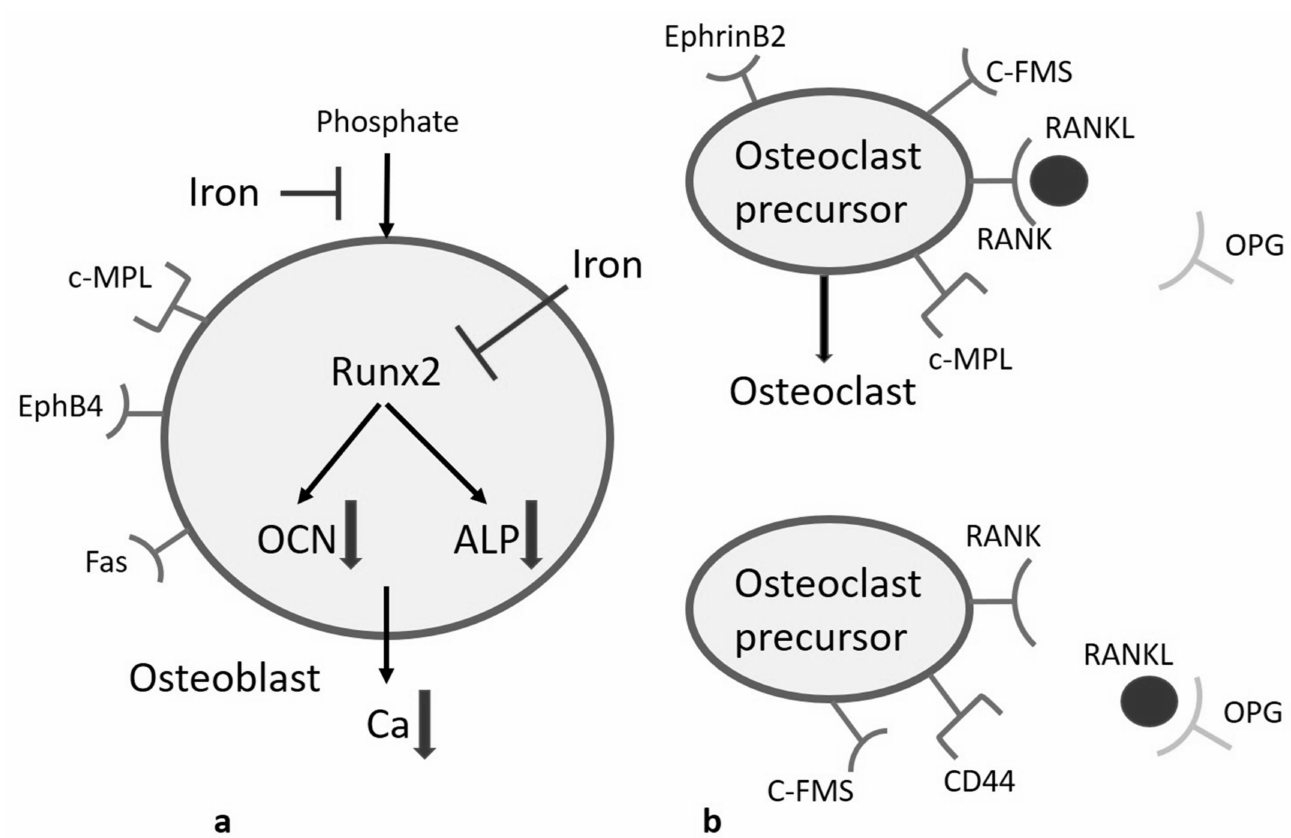
Figure 3. ( a ) Iron decreases osteoblast activity by inhibiting phosphate uptake and downregulating RUNX2. ( b ) OPG plays a role in a decoy receptor for RANKL to inhibit osteoclastogenesis. Abbreviations: RUNX2, Runt-related transcription factor 2; OCN, osteocalcin; ALP, alkaline phosphatase; RANKL, receptor activator of nuclear factor κ B ligand; OPG,